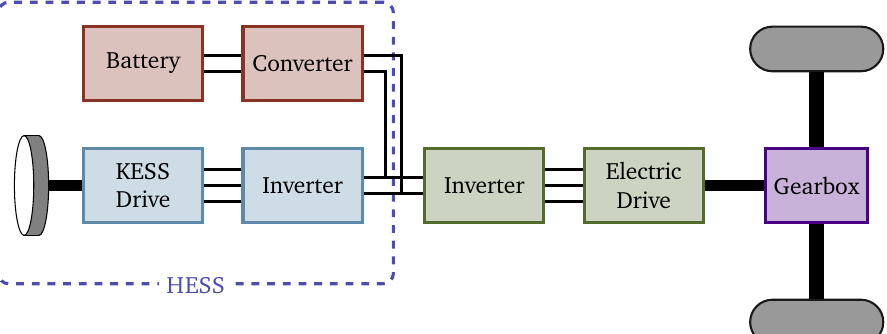
Figure 2. Topology of the electric powertrain, consisting of the hybrid energy storage system, the battery and KESS feeding inverter and the electric drive connected to the final drive. The parameters of the simulation model are presented in Table 3. They are based on the BEB providing the on-board measurement data on the E11 bus line. The auxiliary power equals the average demand measured in the validation cycle, excluding the non-available measurement data from the separate diesel heater of the